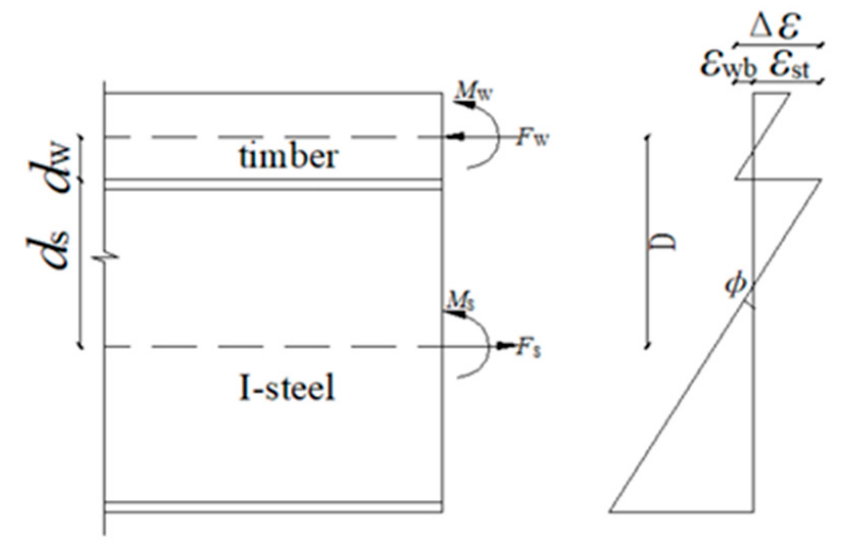
Figure 7. Sectional strain diagram.